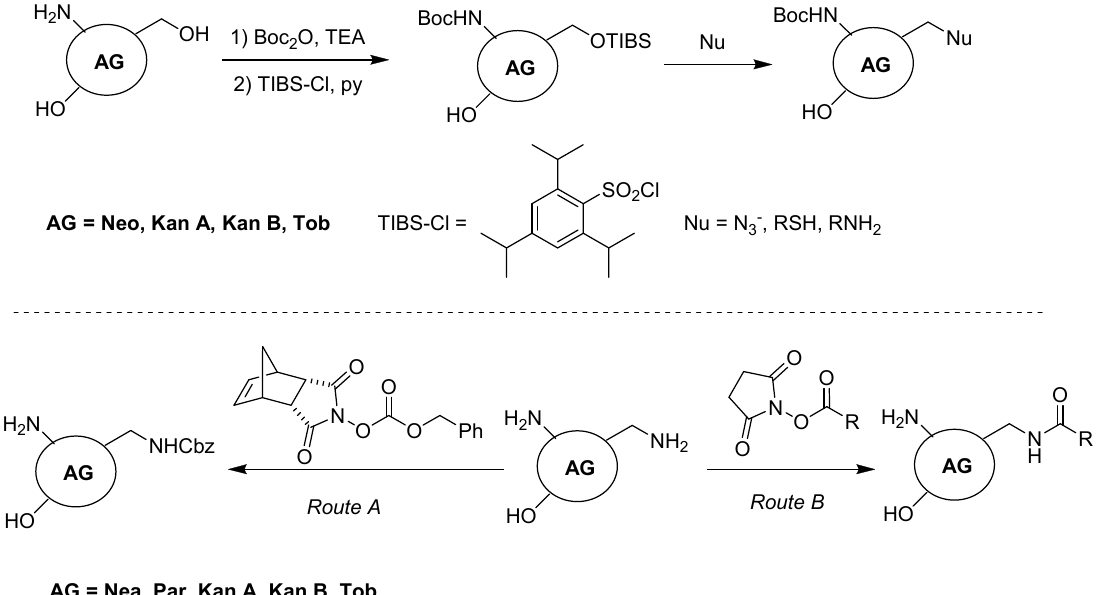
Figure 2. General strategies for the chemoselective functionalization of AGs.